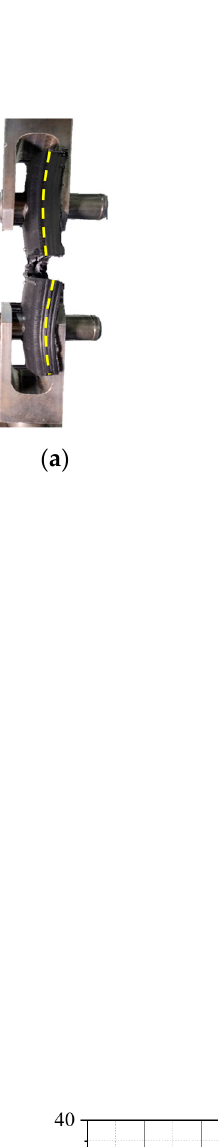
( b ) Figure 18. FEA results of Type B, 450 SDR 9 TWT and WT specimens at F max : ( a ) 𝜎 (cid:3049) and 𝜎 (cid:2869) ; ( b ) 𝑢 (cid:2869) . The transverse deflection ( 𝑢 (cid:2871) ) of the 110 SDR 9 WT specimen is shown in Figure 19. 𝑢 (cid:2871) causes the neutral plane of the specimen to bend during the tensile test and is the larg- est with the 110 SDR 11 size (Position WP5 in Table 8). When the size is increased to 225 SDR 11, 𝑢 (cid:2871) is seen to decrease by about 50% and approximately maintained in larger specimens, as shown in Figure 19. On the other hand, with the TWT specimen, 𝑢 (cid:2871) is smallest with the 110 SDR 9 size and increases incrementally as the size gets larger.